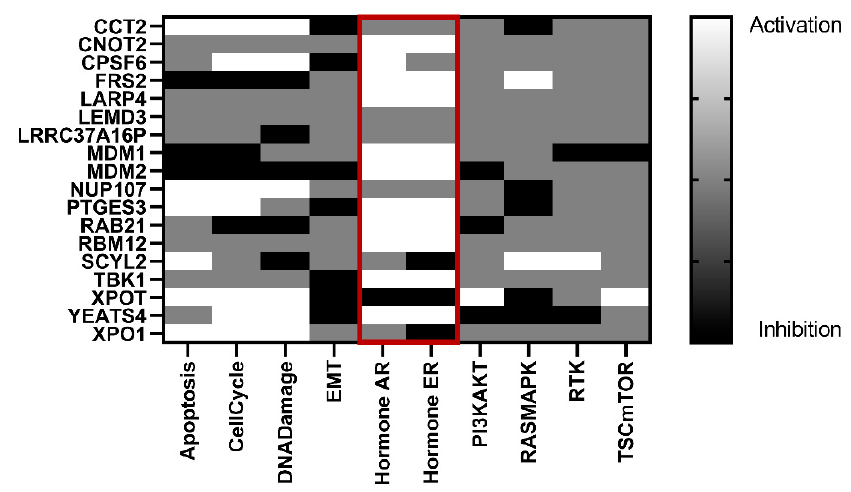
Figure 6. Heat map showing the activated and inhibited pathways based on genes that significantly correlate with CAND1 in ER α -positive breast cancer patients.